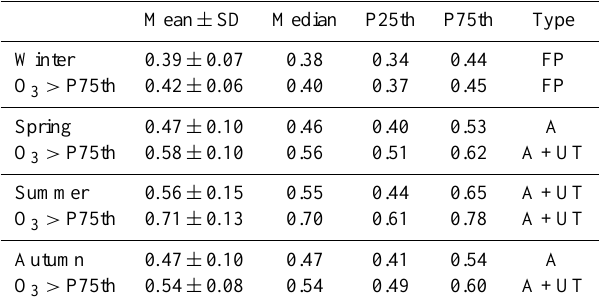
Table 4. Averaged O 3 /CO ratios ( ppbvppbv − 1 ) at IZO for winter, spring, summer and autumn (all cases and those with O 3 > P75 th), and estimated type of air mass (FP = Fresh Pollution; A = Aged air mass; UT = Upper Troposphere). Types of air masses have been la- belled according to the O 3 /CO range values.